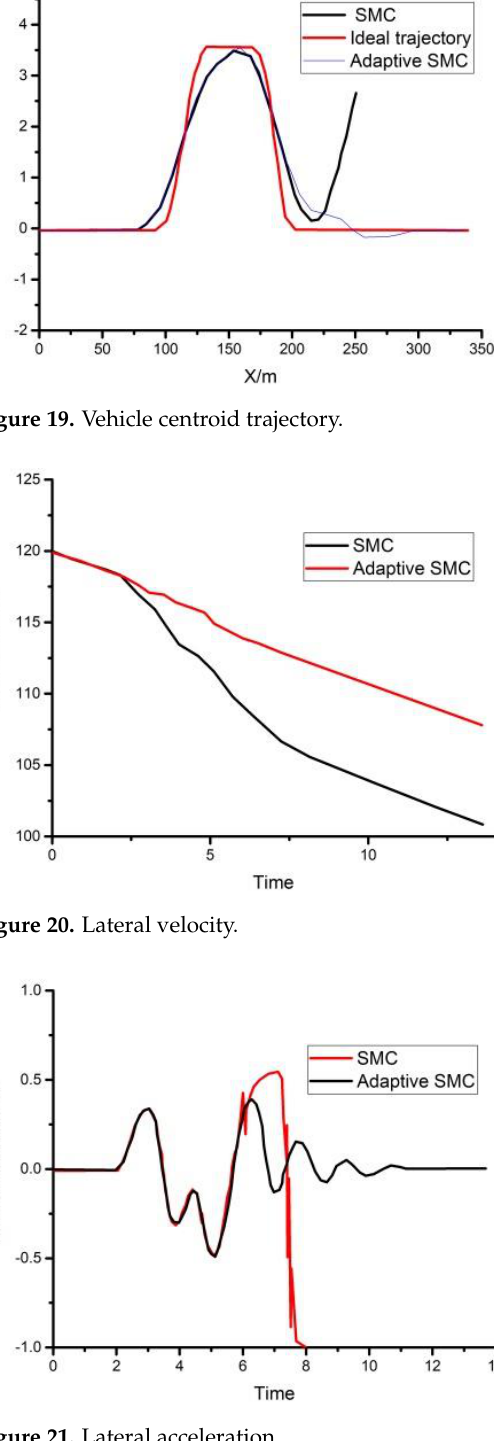
Figure 21. Lateral acceleration. 5. Conclusions In order to improve the dynamic performance and stability of the electric vehicle during changes in road topology, a new adaptive SMC strategy is introduced, which, based on a fuzzy algorithm combined with the QP torque allocation method, is present- ed for the control of an electric vehicle traction system powered by four individual in- duction motors integrated in the front and rear wheels. A completely separate AD5436 control platform is accomplished,as shown in Figure 22. The simulation results illus- trated the presented controller accuracy in the reference to longitudinal speed and in reference to yaw rate tracking. Moreover, this paper illustrated that the proposed sliding mode control method is more robust, accurate, and fast.